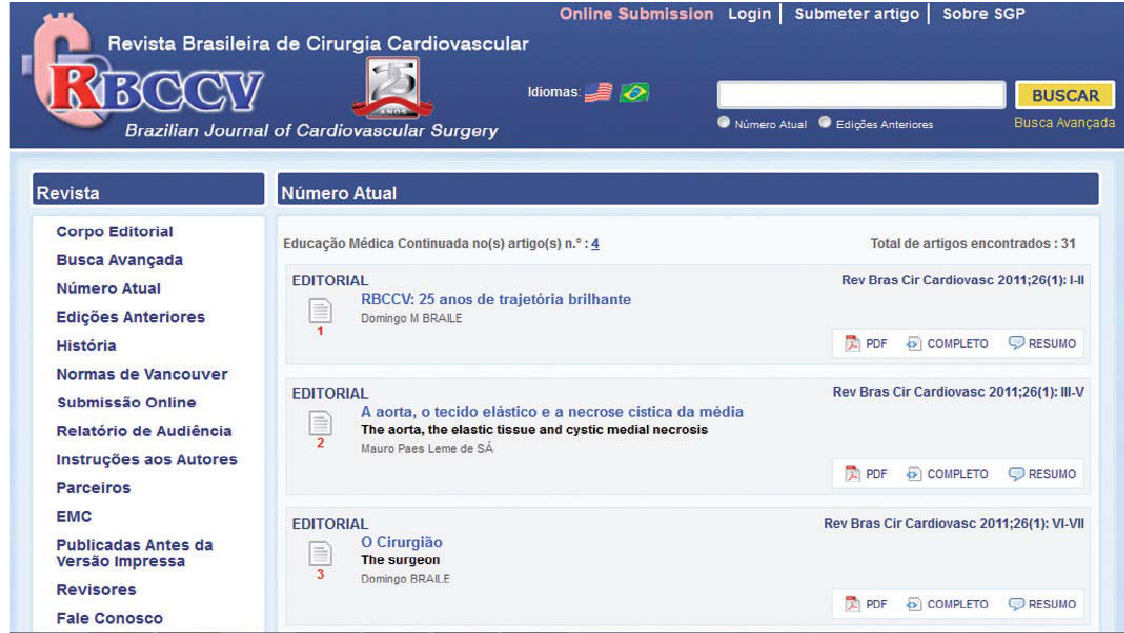
Fig. 1 – Reprodução da nova página inicial do site da